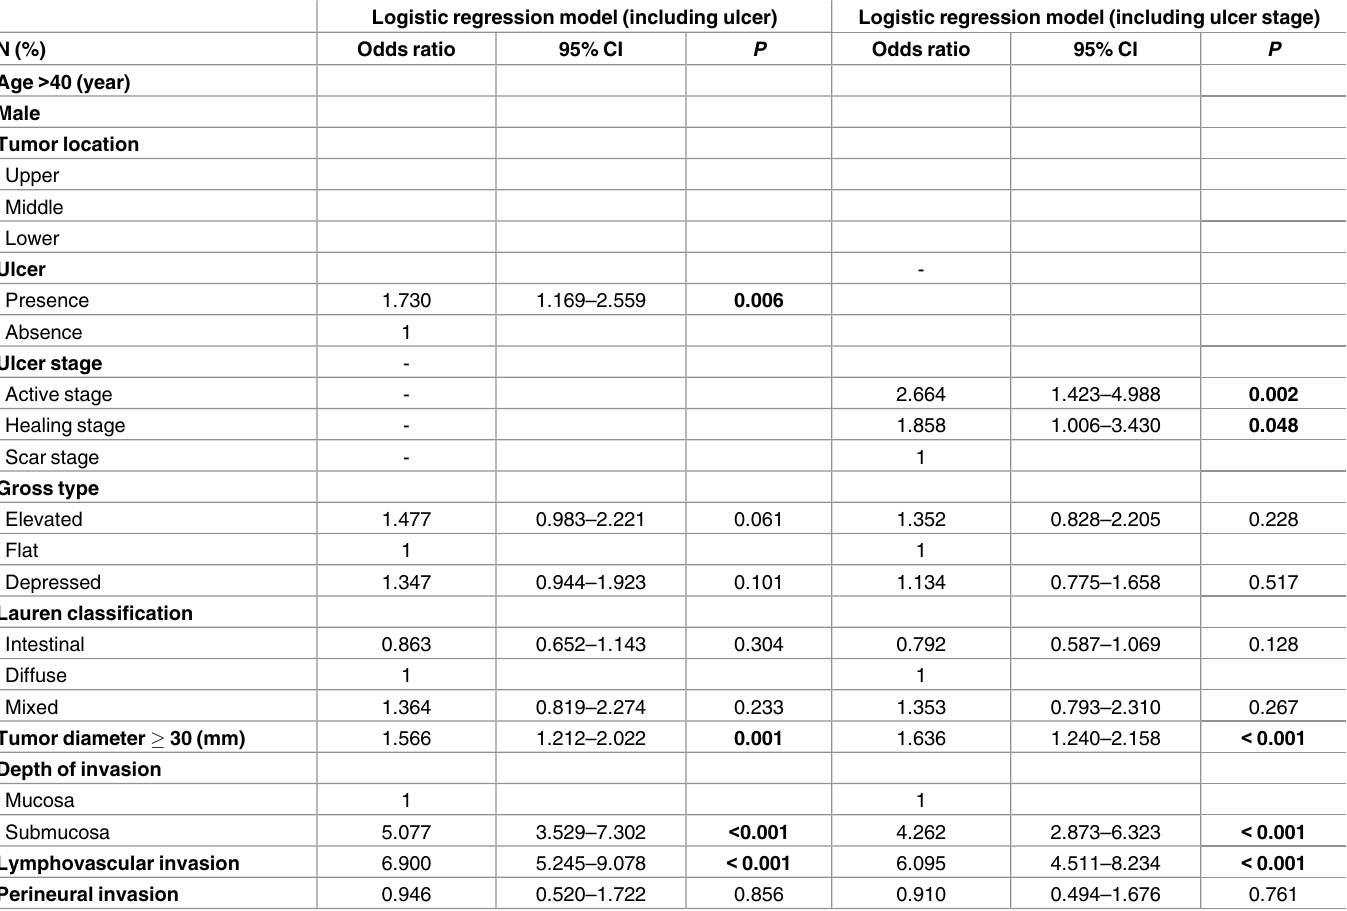
Table 5. Multivariate Analysis of Risk Factors for Lymph Node Metastasis (n =